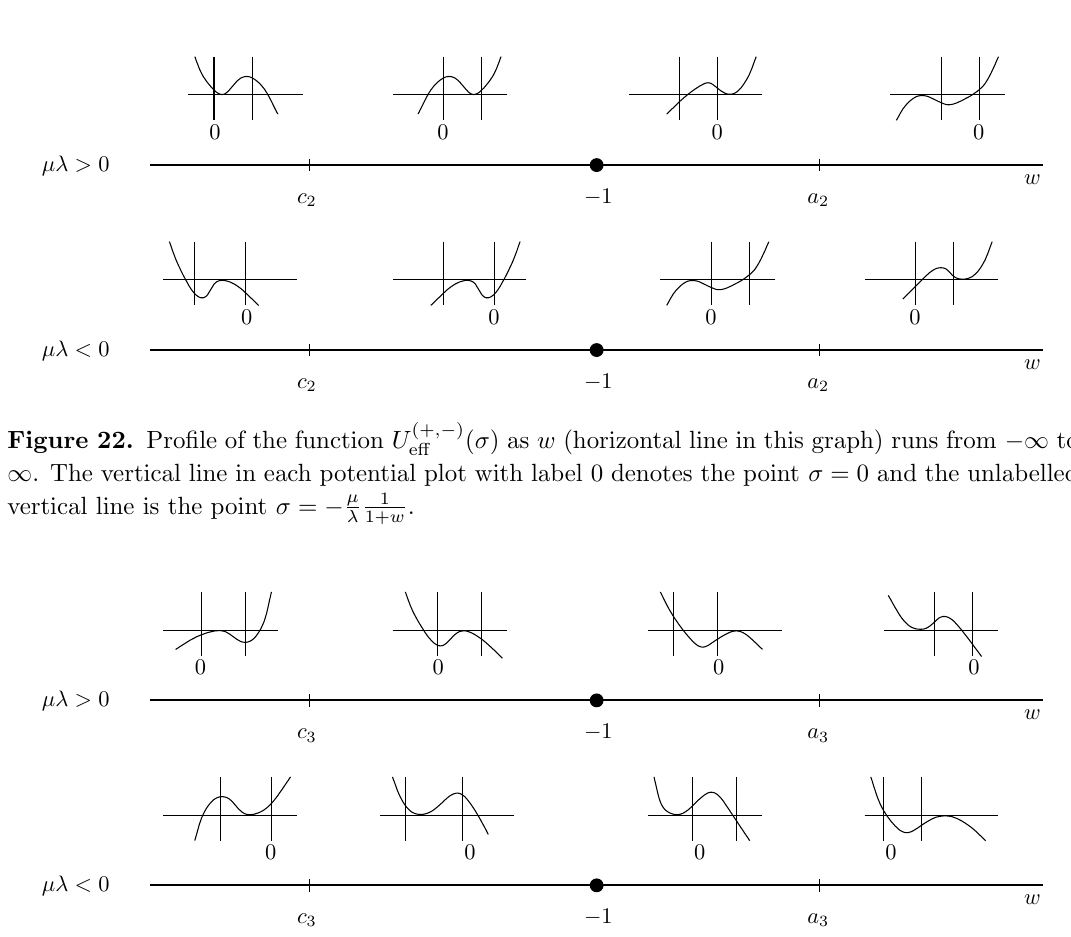
( (cid:27) ) as w (horizontal line in this graph) runs from (cid:0)1 to e(cid:11) 1 . (cid:21) 1+ w